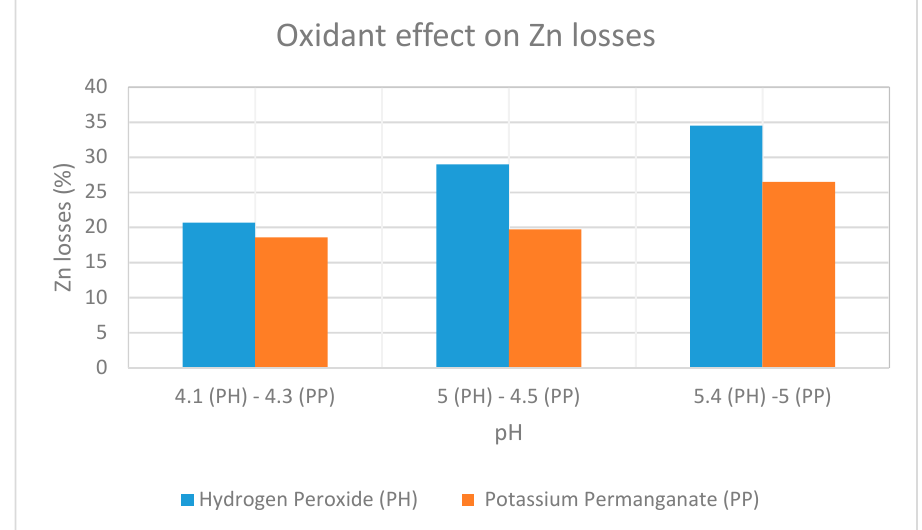
Figure 18. Oxidant effect on Zn losses.